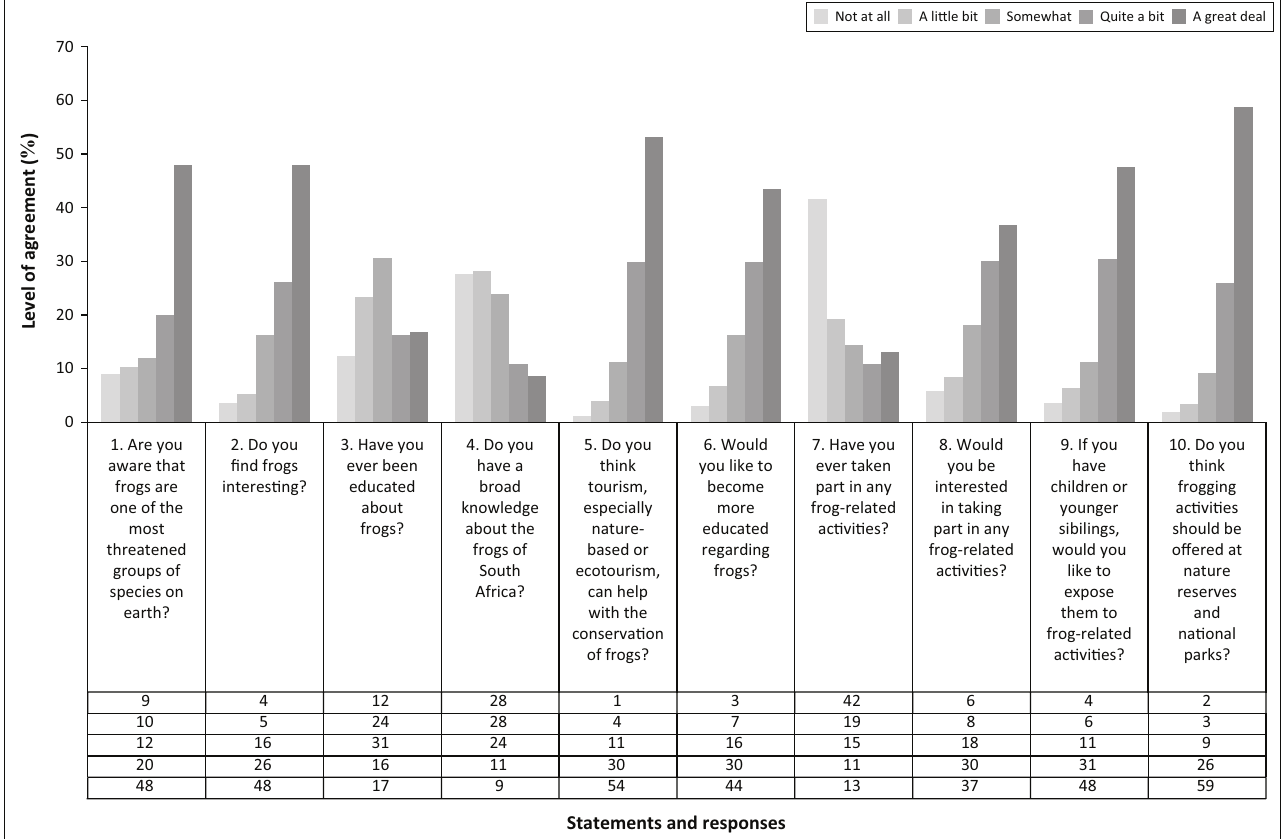
FIGURE 1: Conservation of and educational responses about frogs by